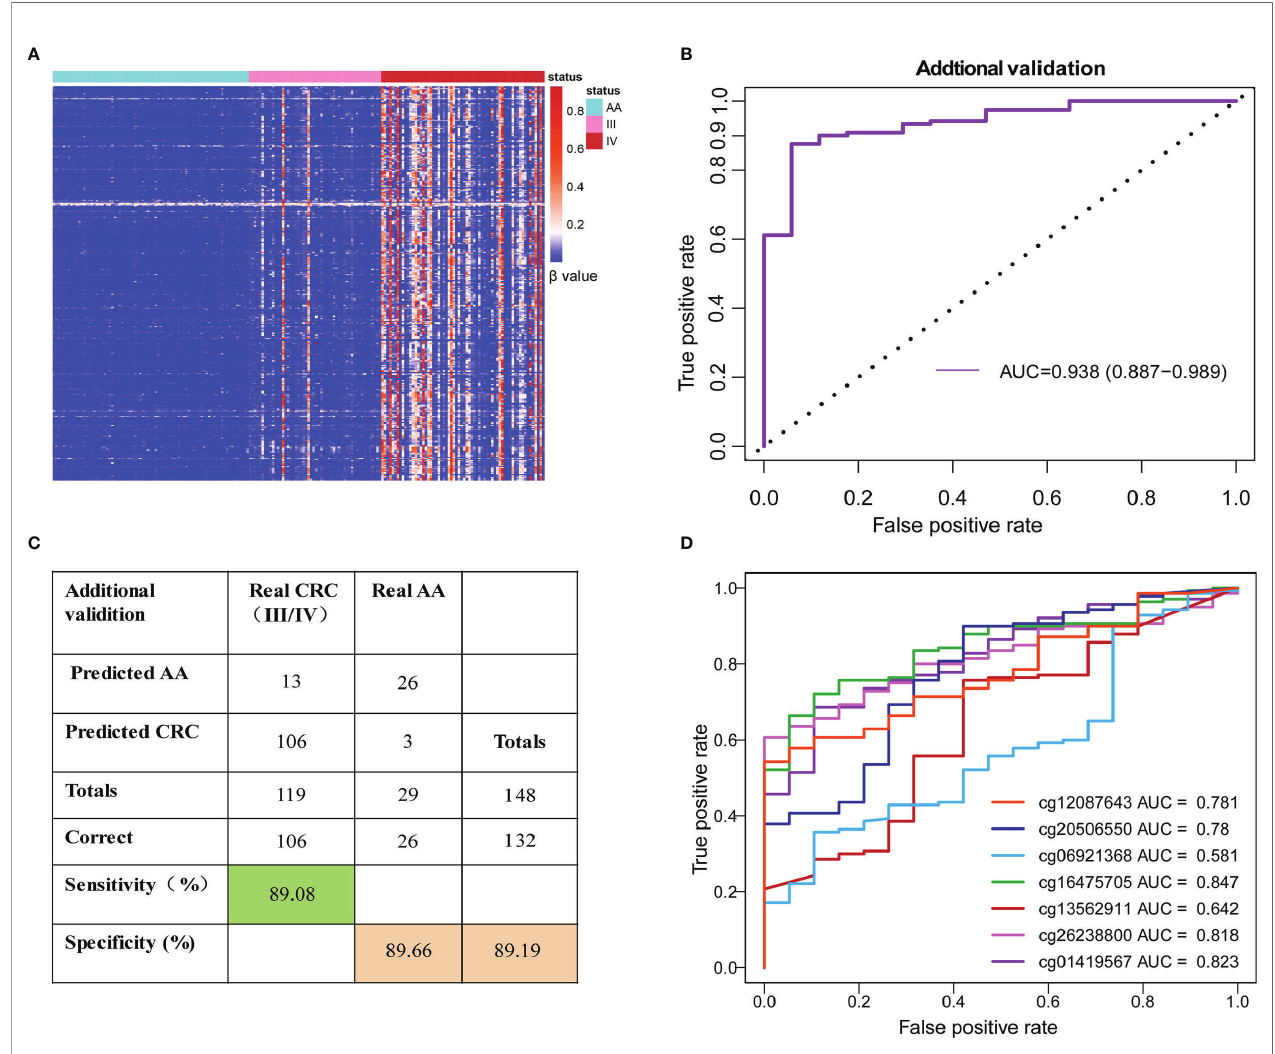
FIGURE 4 | Performance of the SDMBP model in distinguishing AA from advanced CRC. (A) Unsupervised hierarchical clustering of 386 overlapping DMLs (equal to 56 MCBs) in cfDNA from patients with AA and stage III/IV CRC. (B) ROC curves and the corresponding AUCs of the SDMBP model for diagnosing advanced CRC. (C) Confusion matrices built from the model using patients with stage III/IV CRC. (D) ROC curves and the corresponding AUCs of diagnostic performance for each methylation marker in